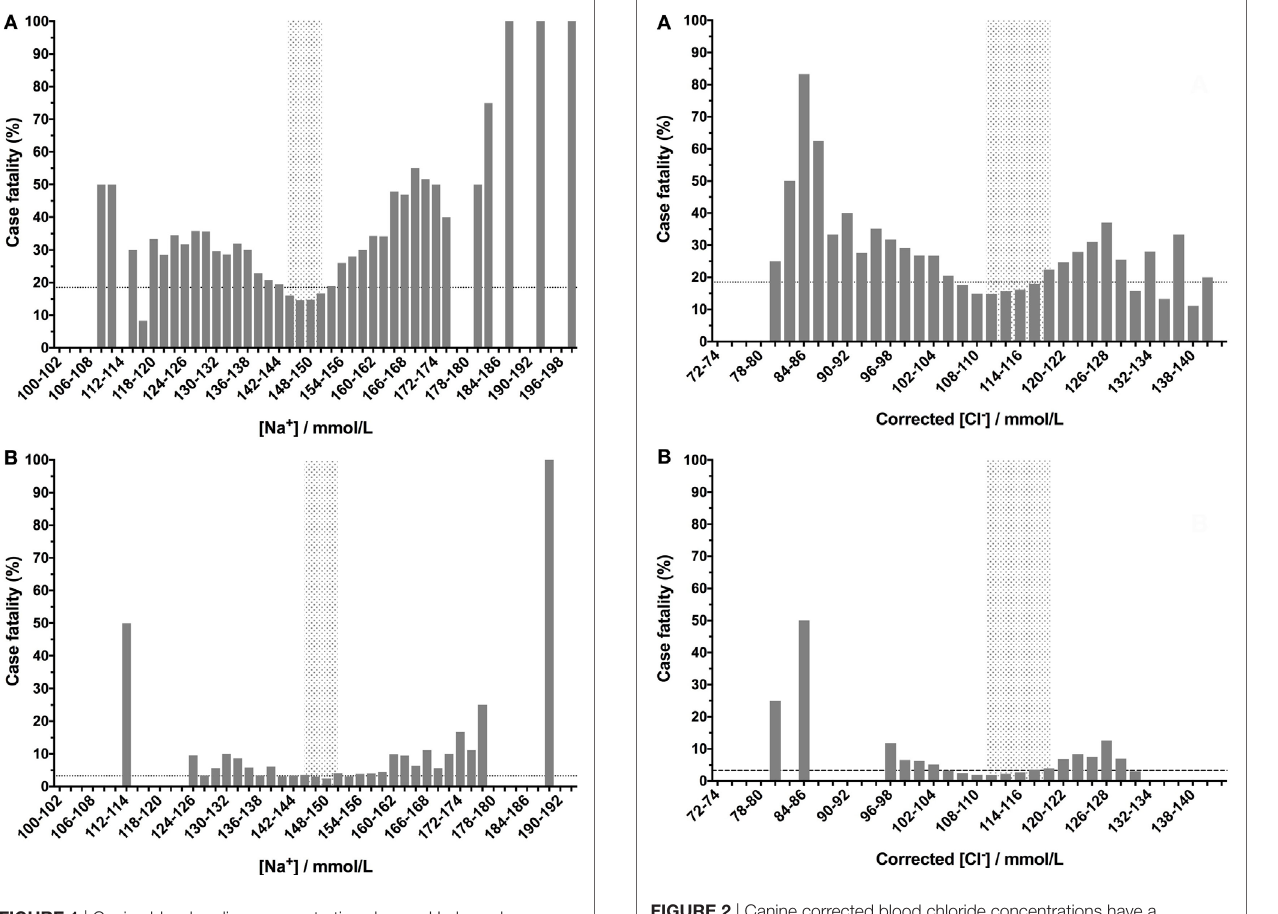
FigUre 1 | Canine blood sodium concentrations have a U-shaped relationship with case fatality rates. Low- or high-sodium concentrations are associated with increased case fatality rates compared to values within the reference interval (gray-shaded box). Sodium concentrations were banded into 2 mmol/L bins, and the percentage case fatality for the patients in each of these subgroups was calculated. The dotted lines denote the case fatality rate across the entire data set (the background case fatality rate). Panel (a) represents data from all samples ( n = 33,117), including those from patients that were euthanized, while panel (b) represents data from patients that survived or died only (i.e., euthanized patients were excluded) ( n =